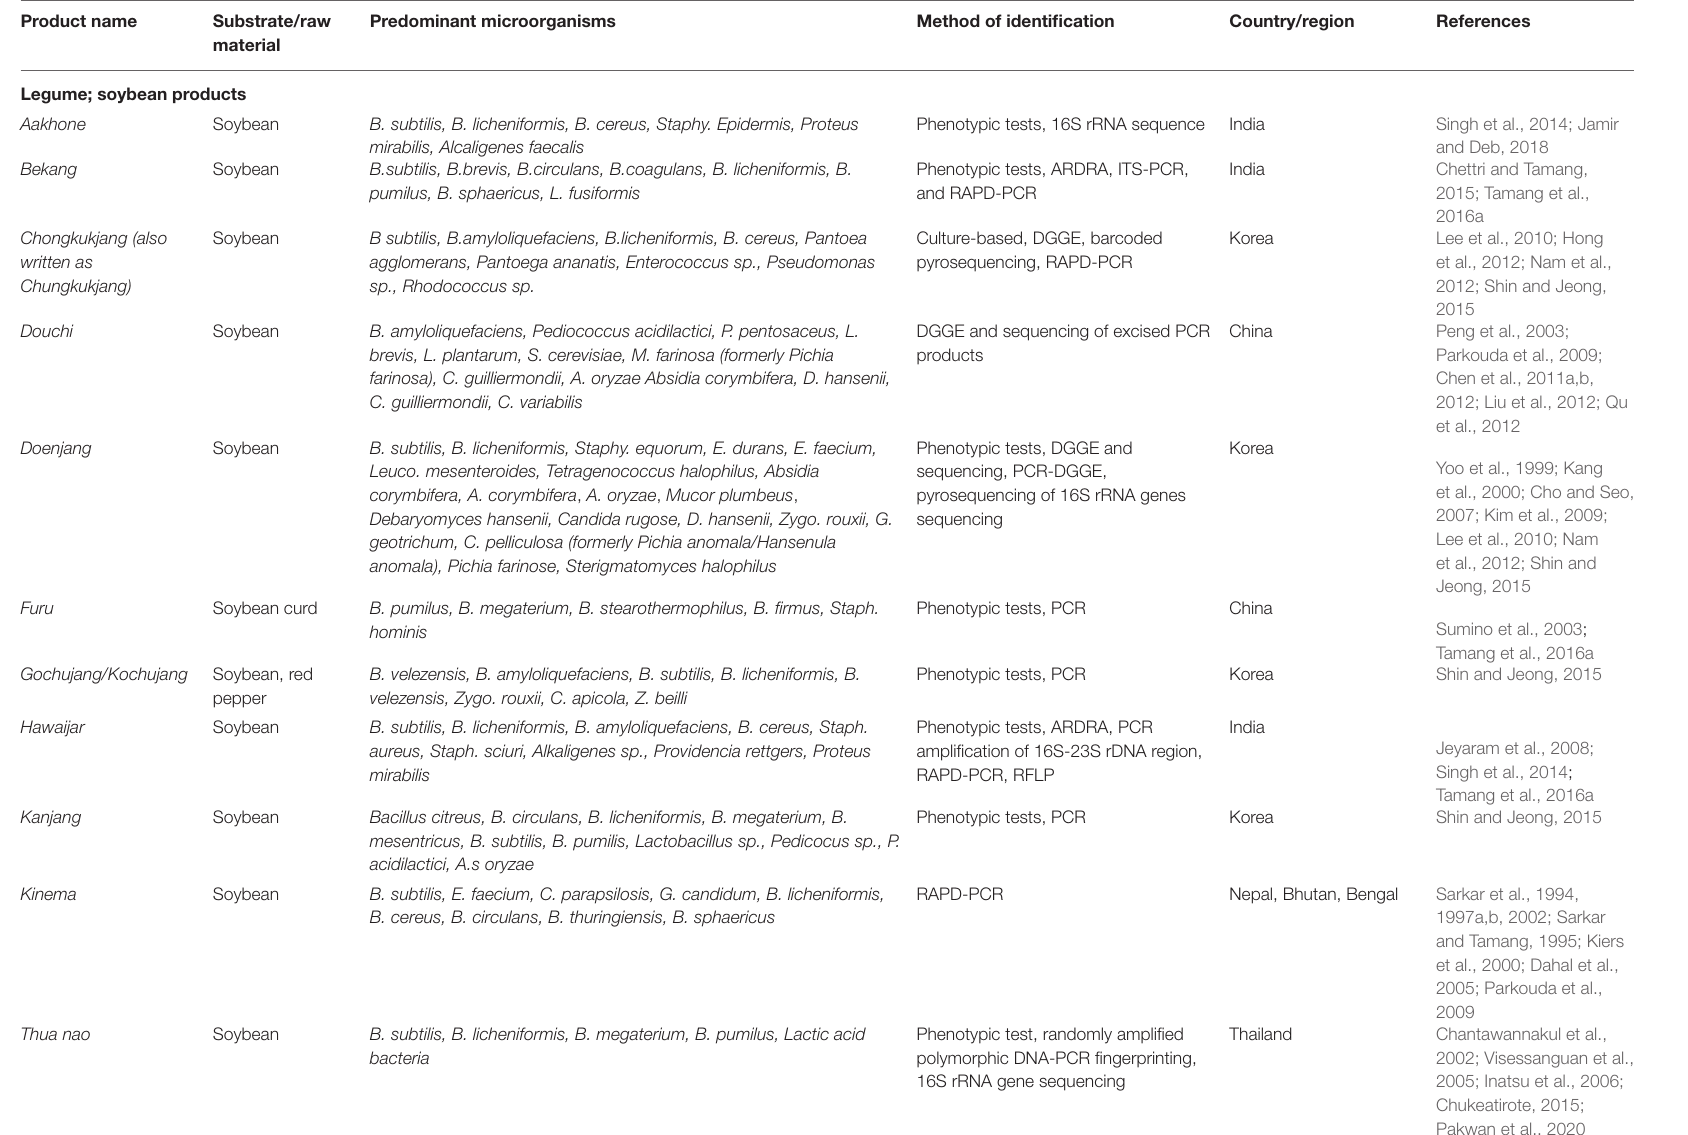
TABLE 1 | Overview of predominant microorganisms occurring in plant-based AFFs in Africa and